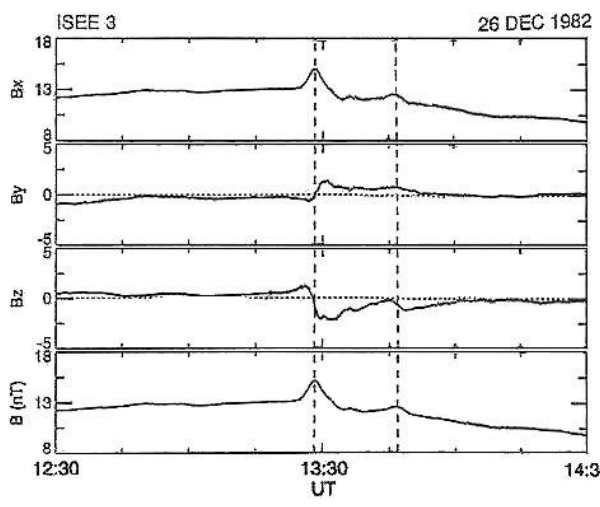
Fig. 5. ISEE 3 magnetic field observations taken in the north lobe of the tail at x =− 73 R E in GSM coordinates (after Slavin et al.,